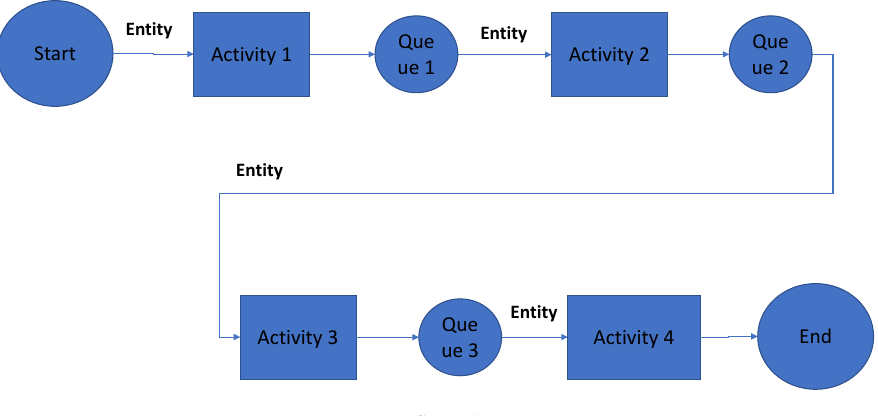
Figure 3. Entity flow diagram (EFD)